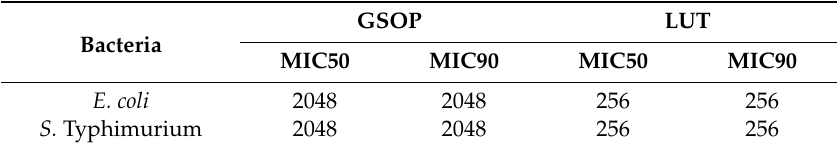
Table 1. Minimum inhibitory concentration (MIC) values of grape seed oligomeric proanthocyanidins (GSOPs) and luteolin (LUT) against the tested bacterial strains. Values are expressed as µ g / mL, n = 8 strains for both bacterial